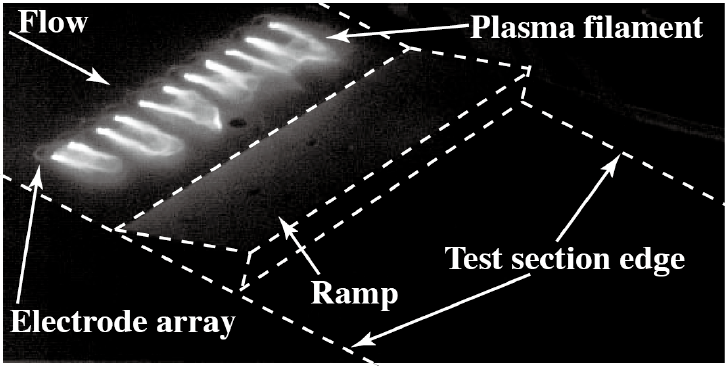
Figure 5. Snapshot view of plasma filament with high-speed imaging, 100 μ s exposure time.